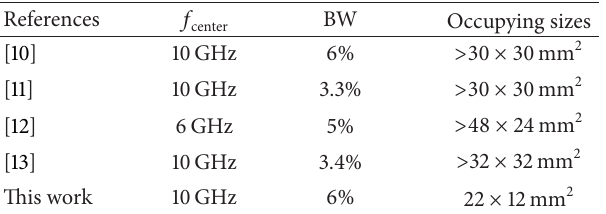
Table 2: Comparisons with some conventional SIW filters.